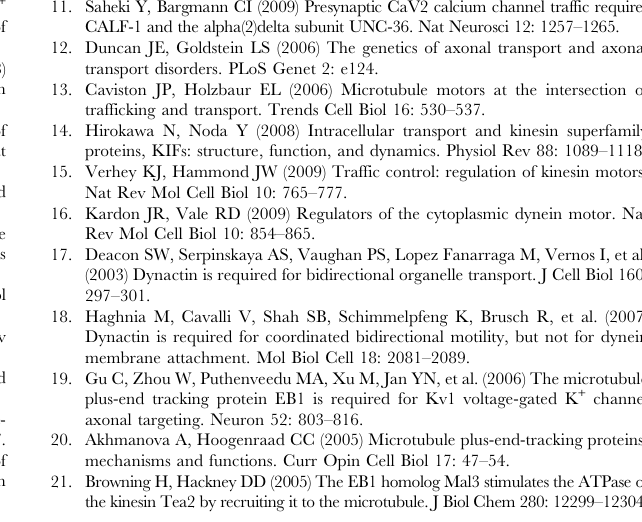
indicator knocked down endogenous EB1 (green). (B) KIF3A siR2 (red) knocked down endogenous KIF3A (green). Neurons were transfected with siRNA plasmids at 4 DIV, and fixed and stained at 8 DIV. The statistics are shown in Fig. 2A. Found at: doi:10.1371/journal.pone.0011931.s004 (9.73 MB TIF) Figure S3 Neurons co-transfected with YFP-Kv1.2, Kv b 2 and siRNA vectors Hippocampal neurons were transfected at 4 DIV, fixed and stained at 8-9 DIV. Signals are inverted. Neurons co- transfected with YFP-Kv1.2 (green in the merged), Kv b 2, and either control siRNA (A) or EB1 siR2 (B) plasmids (red in the merged), were stained for endogenous EB1 (blue in the merged). Neurons co-transfected with YFP-Kv1.2, Kv b 2, and either control siRNA (C) or KIF3A siR2 (D) plasmids, were stained for endogenous KIF3A (blue in the merged). Arrows, axons; Arrowheads, dendrites. The boxed areas are enlarged for four times and shown in Fig. 2B. Scale bars, 100 m m. Found at: doi:10.1371/journal.pone.0011931.s005 (9.82 MB TIF) Figure S4 Co-movement of fluorescently-tagged Kv b 2/EB1 and Kv1.2/KIF3A (A) A kymograph for EB1-YFP plus-end tracking. (B) A kymograph for YFP-Kv b 2. (C) Anterograde co- movement of EB1-YFP and CFP-Kv b 2. (D) Retrograde co- movement of EB1-YFP and CFP-Kv b 2. Blue arrowheads, EB1 plus-end tracking. Red arrow, anterograde co-movement. Red arrowheads, retrograde co-movement. (E) Anterograde and retrograde co-movement of CFP-Kv1.2 and KIF3A-YFP. Found at: doi:10.1371/journal.pone.0011931.s006 (10.27 MB